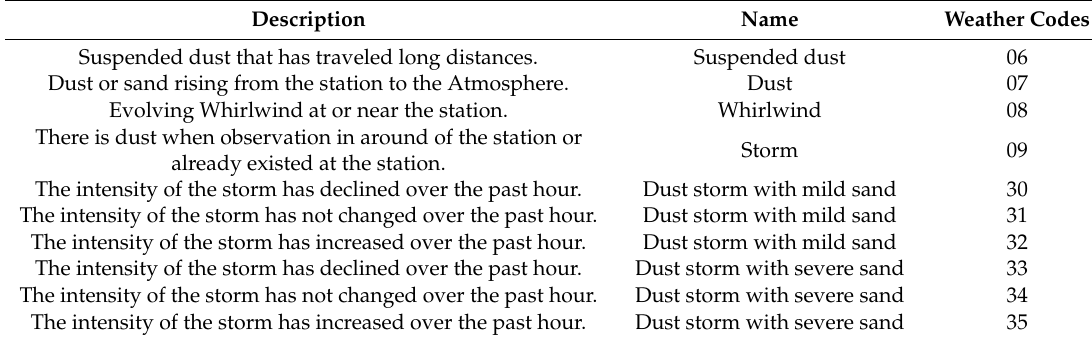
Table 1. Dust-related weather codes in synoptic station reports.